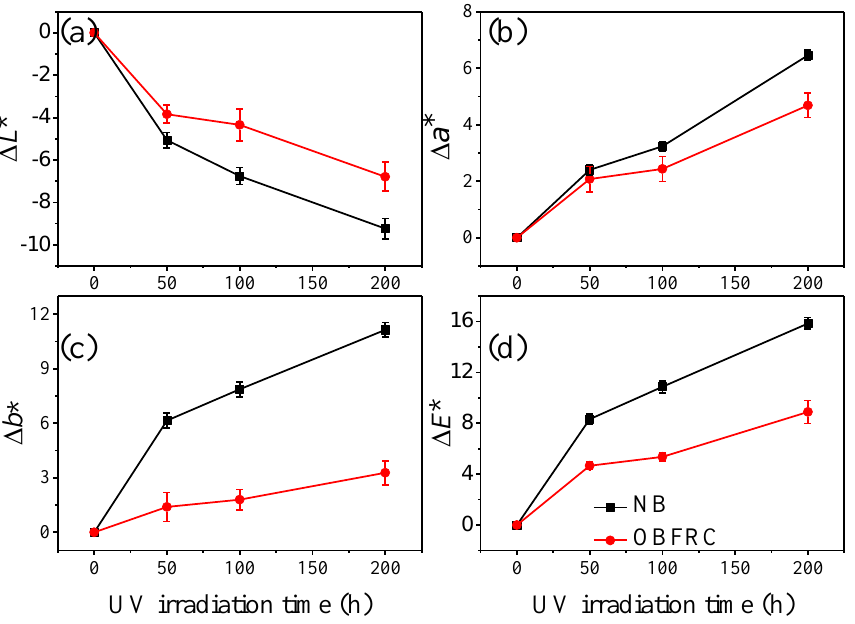
Figure 5. ( a ) ∆ L *, ( b ) ∆ a *, ( c ) ∆ b *, and ( d ) ∆ E * values for NB and OBFRC as functions of UV Figure 5. ( a ) Δ L *, ( b ) Δ a *, ( c ) Δ b *, and ( d ) Δ E * values for NB and OBFRC as functions of UV irradi- irradiation ation time.